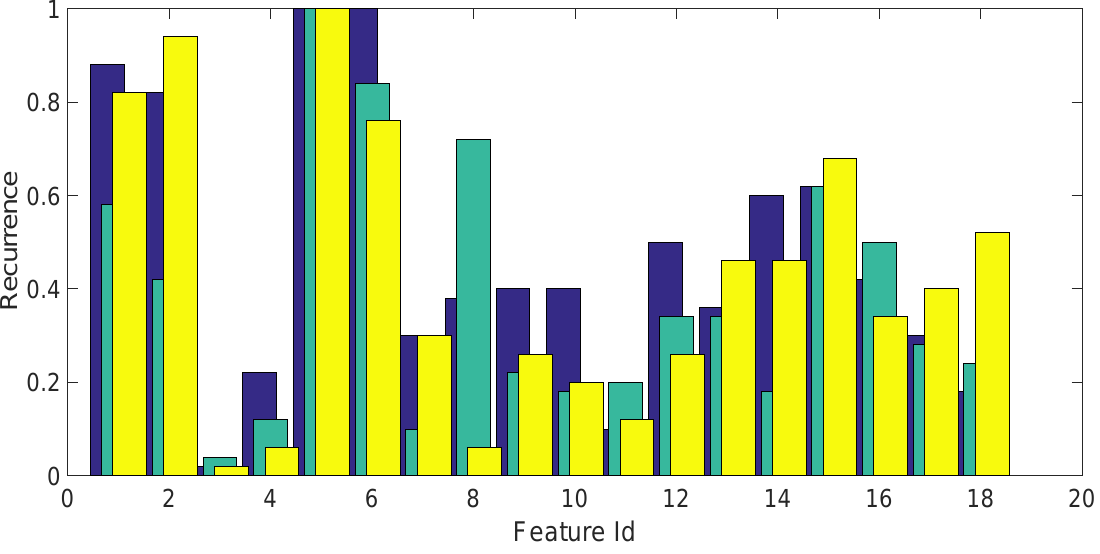
Figure 5. Frequency of occurrence of the 18 statistical features on the three folds, averaged over the 50 repetitions of the feature selection process. The three folds are depicted in three different